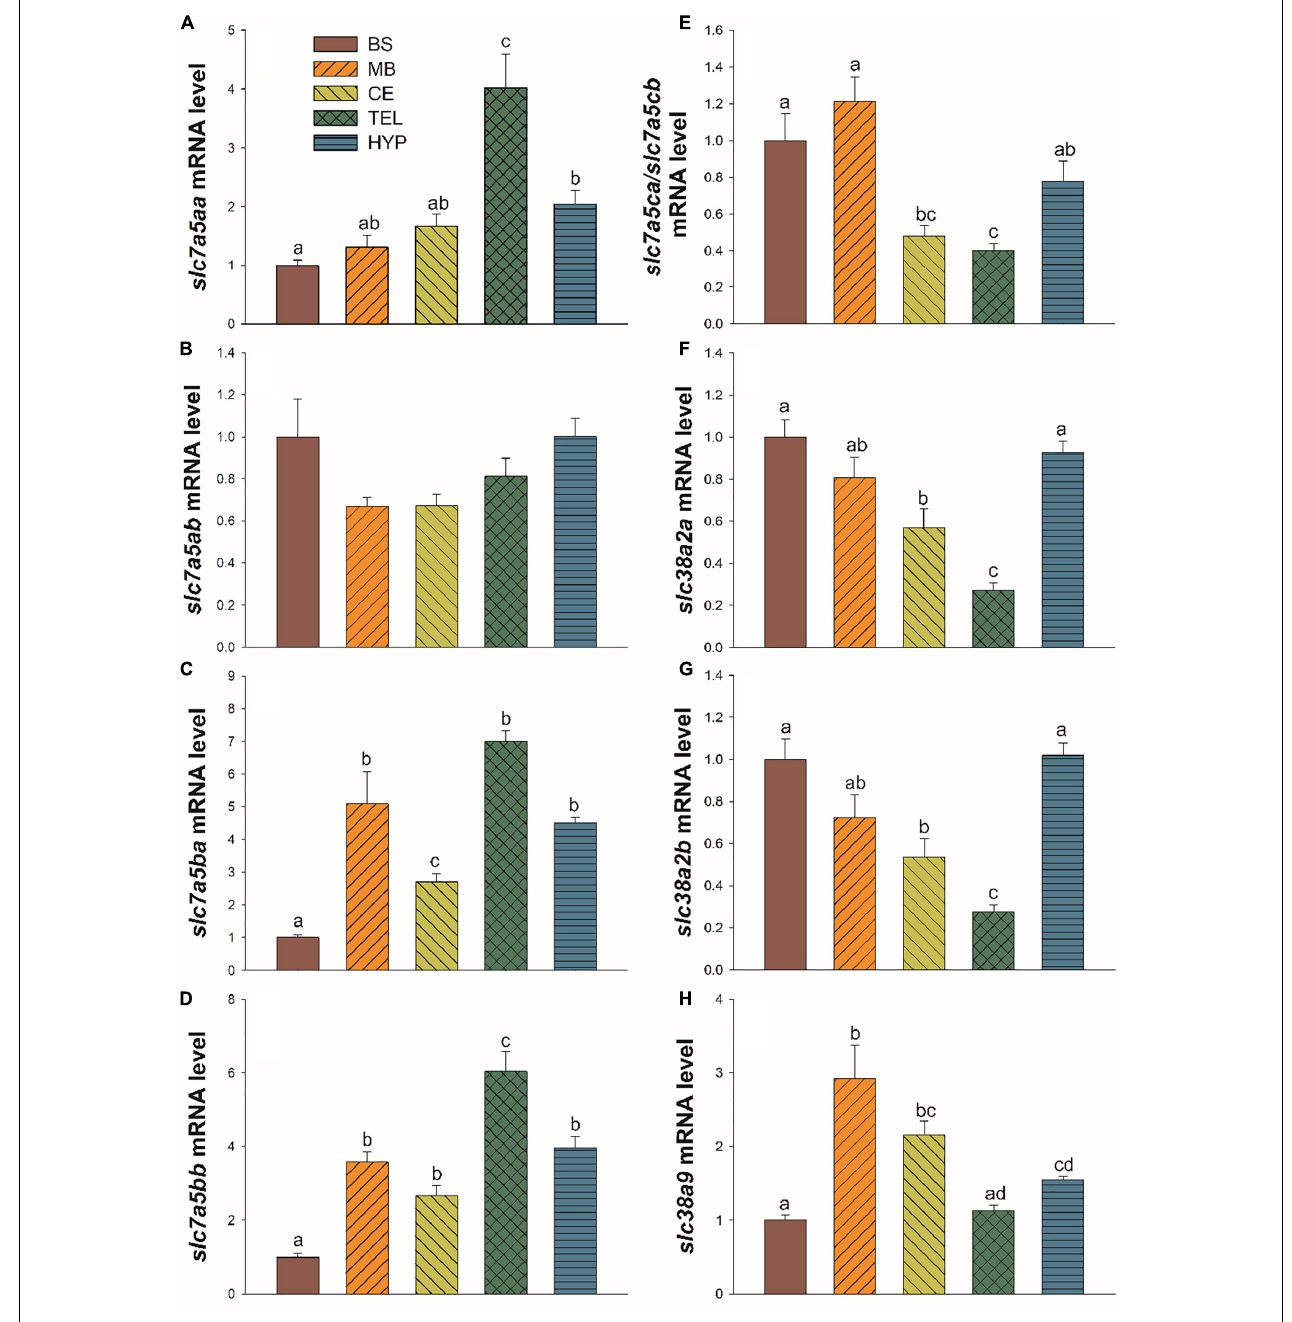
FIGURE 4 | Brain distribution of mRNA level of slc7a5aa (A) , slc7a5ab (B) , slc7a5ba (C) , slc7a5bb (D) , slc7a5ca / slc7a5cb (E) , slc38a2a (F) , slc38a2b (G) , and slc38a9 (H) in brainstem (BM), midbrain (MB), cerebellum (CE), telencephalon (TEL), and hypothalamus (HYP) of Atlantic salmon after 4 weeks of feeding with control leucine diet (CL; 27.3 g/kg of leucine). Each value is the mean ± SEM of n = 6 samples per tissue. Gene expression results are relative to brainstem (BM) and are normalised by actb ( β -actin). Different letters indicate significant differences ( P < 0.05) among different tissues.